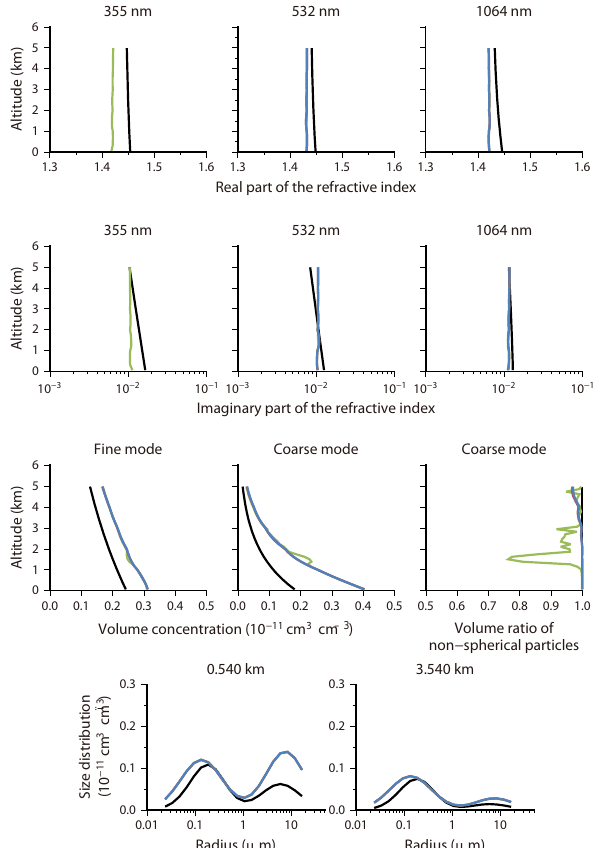
Figure 4. Retrieval results from the simulated data for the conti- nental average aerosol: the real and imaginary parts of the refrac- tive index, the volume concentrations of the fine and coarse modes, the volume ratio of the non-spherical particles to total particles in the coarse mode, and the size distributions at two altitudes. “True” values are shown by the black lines, and the colored lines indicate retrievals from Type 1 data set (MIEL data at 532 and 1064nm) (blue), Type 2 data set (MIEL data at 532 and 1064 nm; HSRL data at 532nm) (red), and Type 3 data set (MIEL data at 532 and 1064nm; HSRL data at 355 and 532nm) (green). The red and blue lines completely overlap.